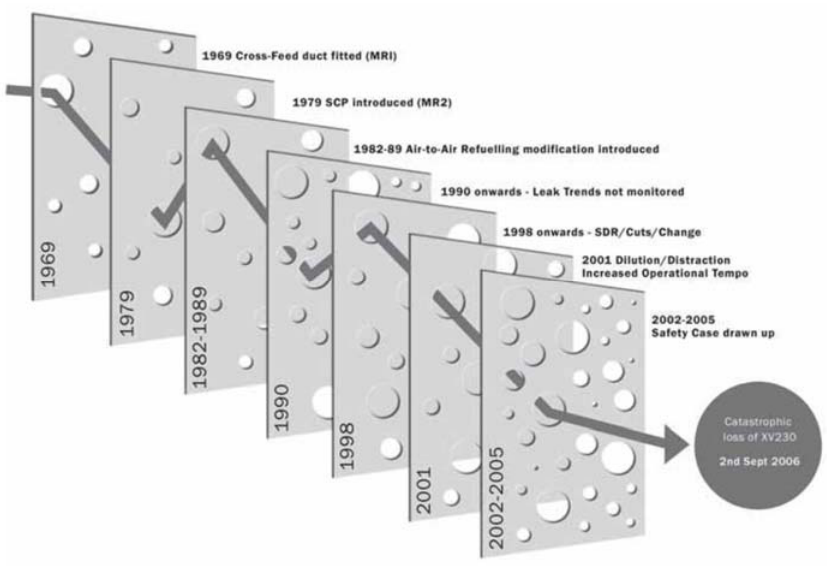
Figure 6. Safety “Swiss Cheese Model” applied to a specific event (from [30]).